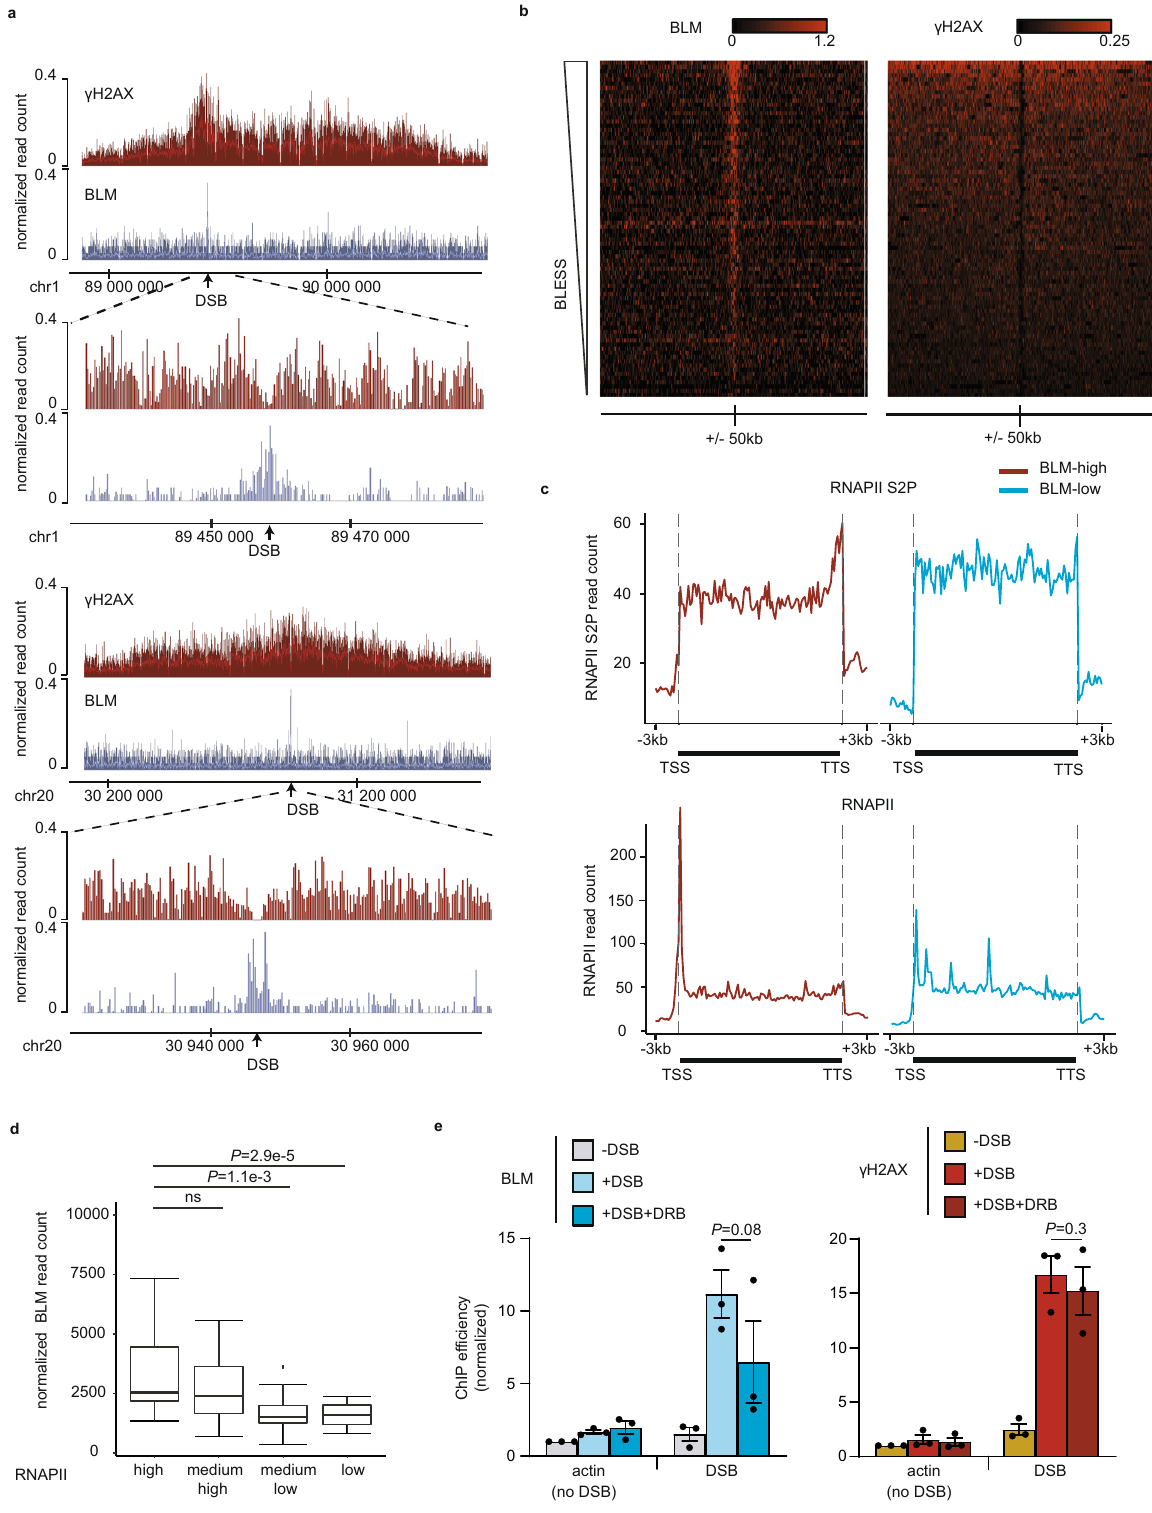
loci to recruit BLM was further con fi rmed by visual inspection of the pro fi les of BLM and RNAPII ChIP-seq as well as examining RNA-seq data at individual DSBs (Supplementary Fig. 1h). To determine the in fl uence of prior transcriptional activity on BLM recruitment, we next performed BLM ChIP in the presence of